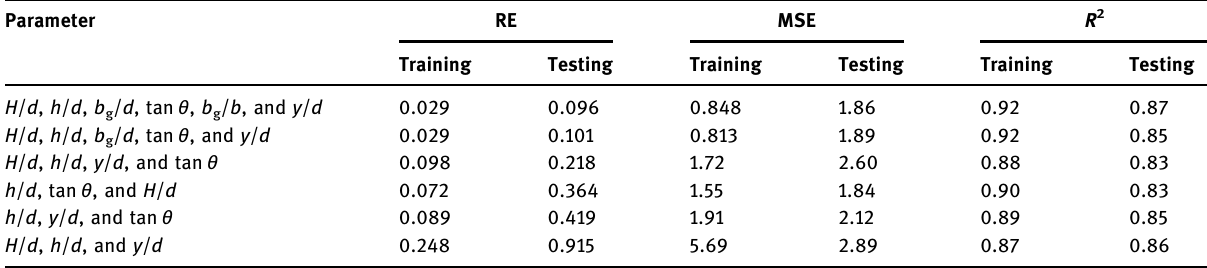
Table 3: Results of sensitivity analysis Parameter RE MSE R 2 Training Testing